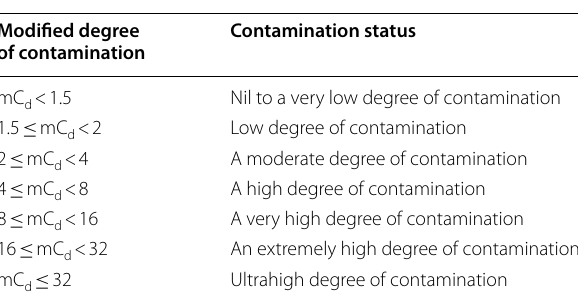
Table 5 Classification of pollution load index Pollution load